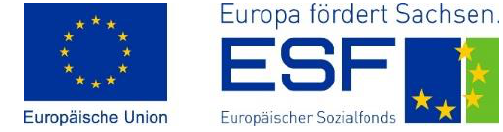
Fig. 4. Three dimensional micrograph of a cylindrical lens fab- ricated in calcium fluoride (H = 3.5 J/cm 2 , overlap 98 %).